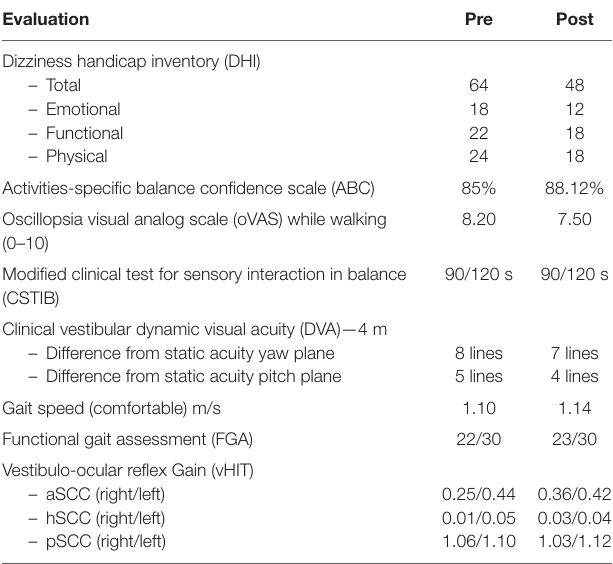
taBle 1 | Comparison between pre- and post-vestibular rehabilitation